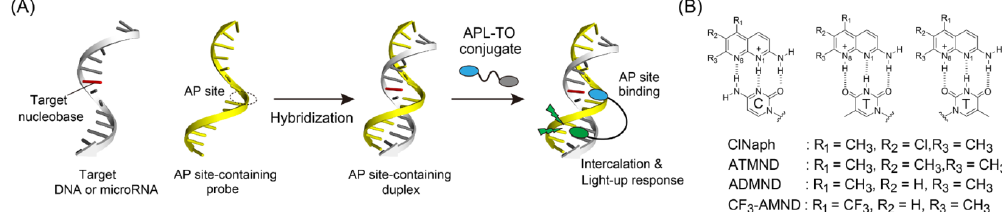
Figure 1. ( A ) Schematic illustration of the analysis of target DNA or microRNA sequences based on the binding of abasic (AP) site-binding ligands conjugated with thiazole orange conjugates (APL–TO) in combination with an AP site-containing probe for hybridization; ( B ) Chemical structures of chloro-substituted 2-amino-5,7-dimethyl-1,8-naphthyridine (ClNaph) and its related derivatives. Proposed binding of these ligands with cytosine and thymine (two possible patterns) are also shown.